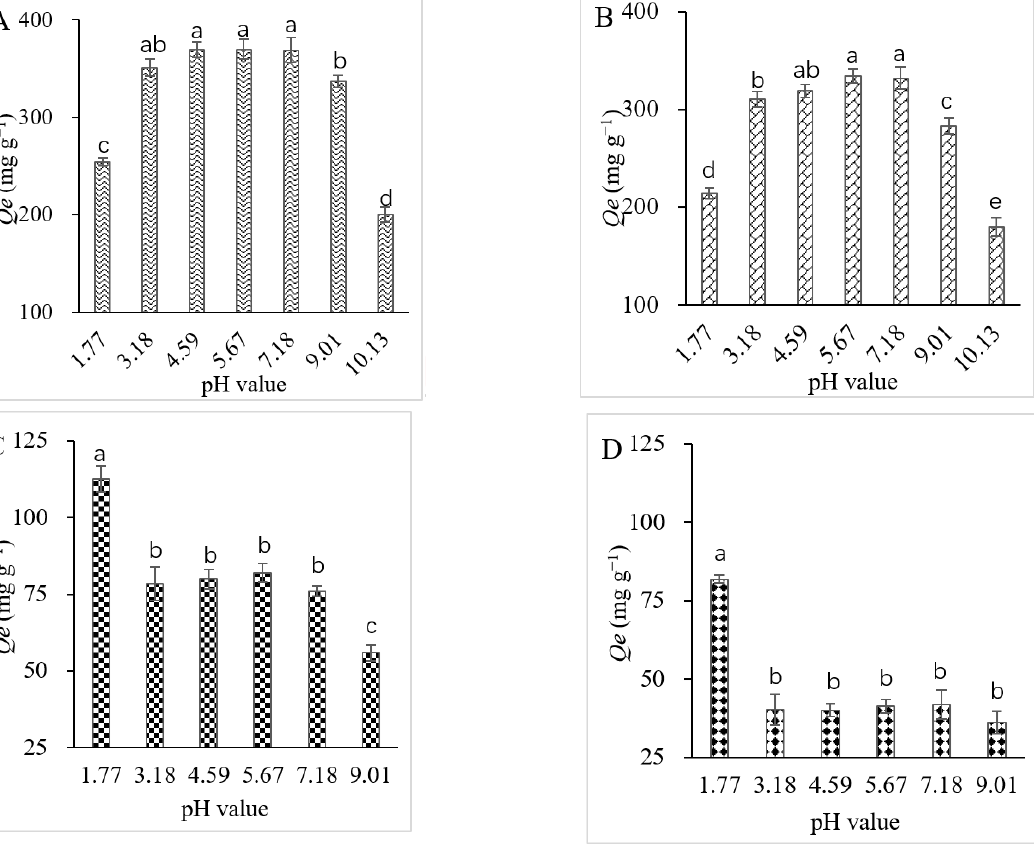
Figure 2. Effect of pH on adsorption of L-theanine and caffeine by ZGSPC106Na and D001SD resins. ( A , B ), adsorption of L-theanine by ZGSPC106Na and D001SD; ( C , D ), adsorption of caffeine by ZGSPC106Na and D001SD; Qe , adsorption capacity at equilibrium. Different letters (a–e) indicate significantly different adsorption capacities at p < 0.05.